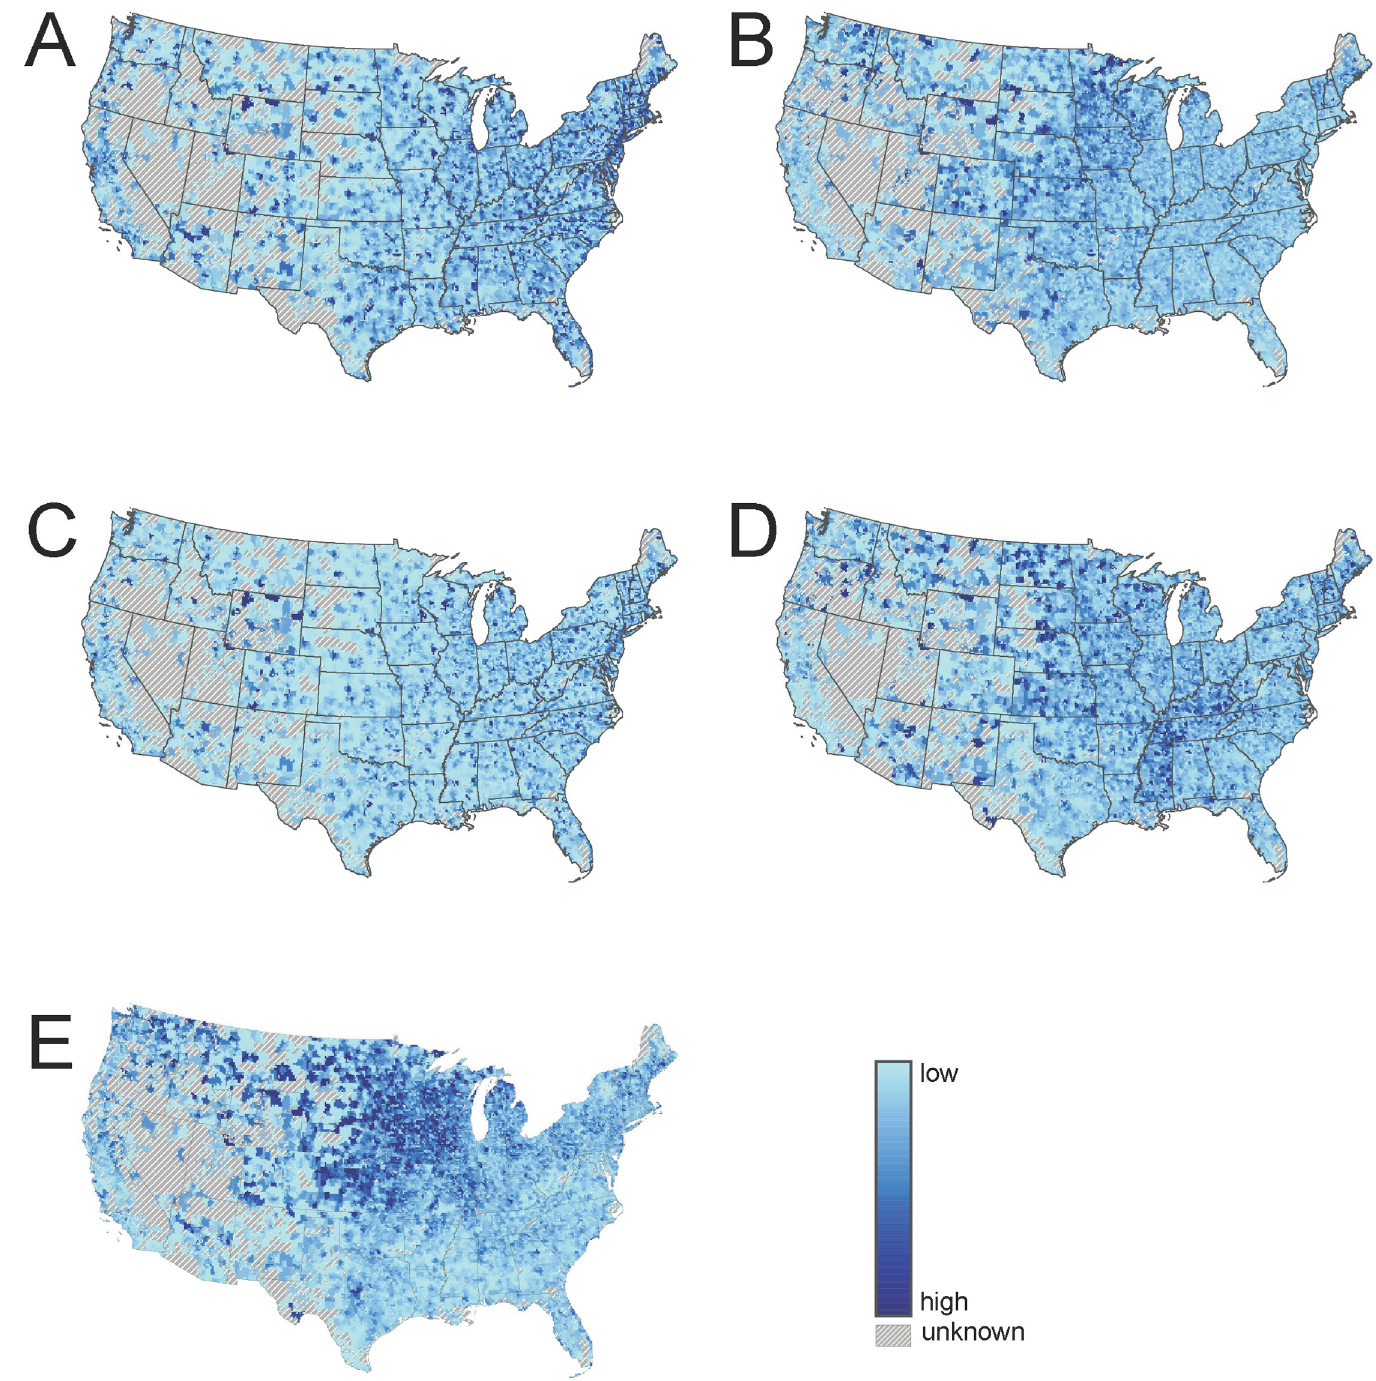
Fig 1. Provider spatial accessibility. Accessibility for internal medicine physicians (A), family medicine physicians (B), specialists (C), nurse practitioners (D), and chiropractors (E) across the contiguous United States.